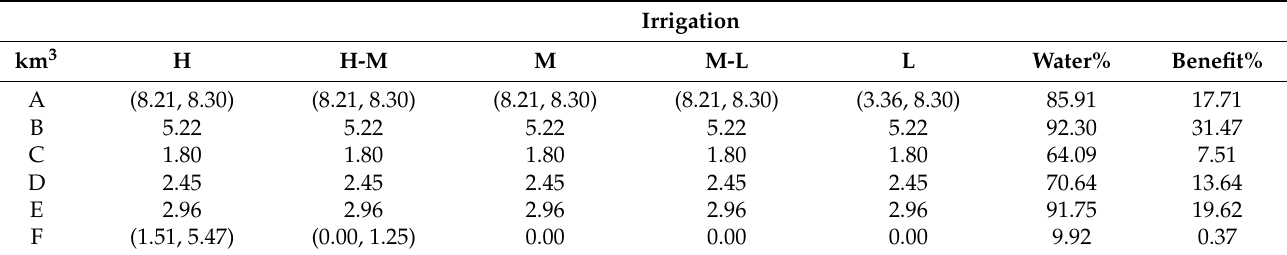
Table 13. Water allocation scheme in the sector of irrigation.